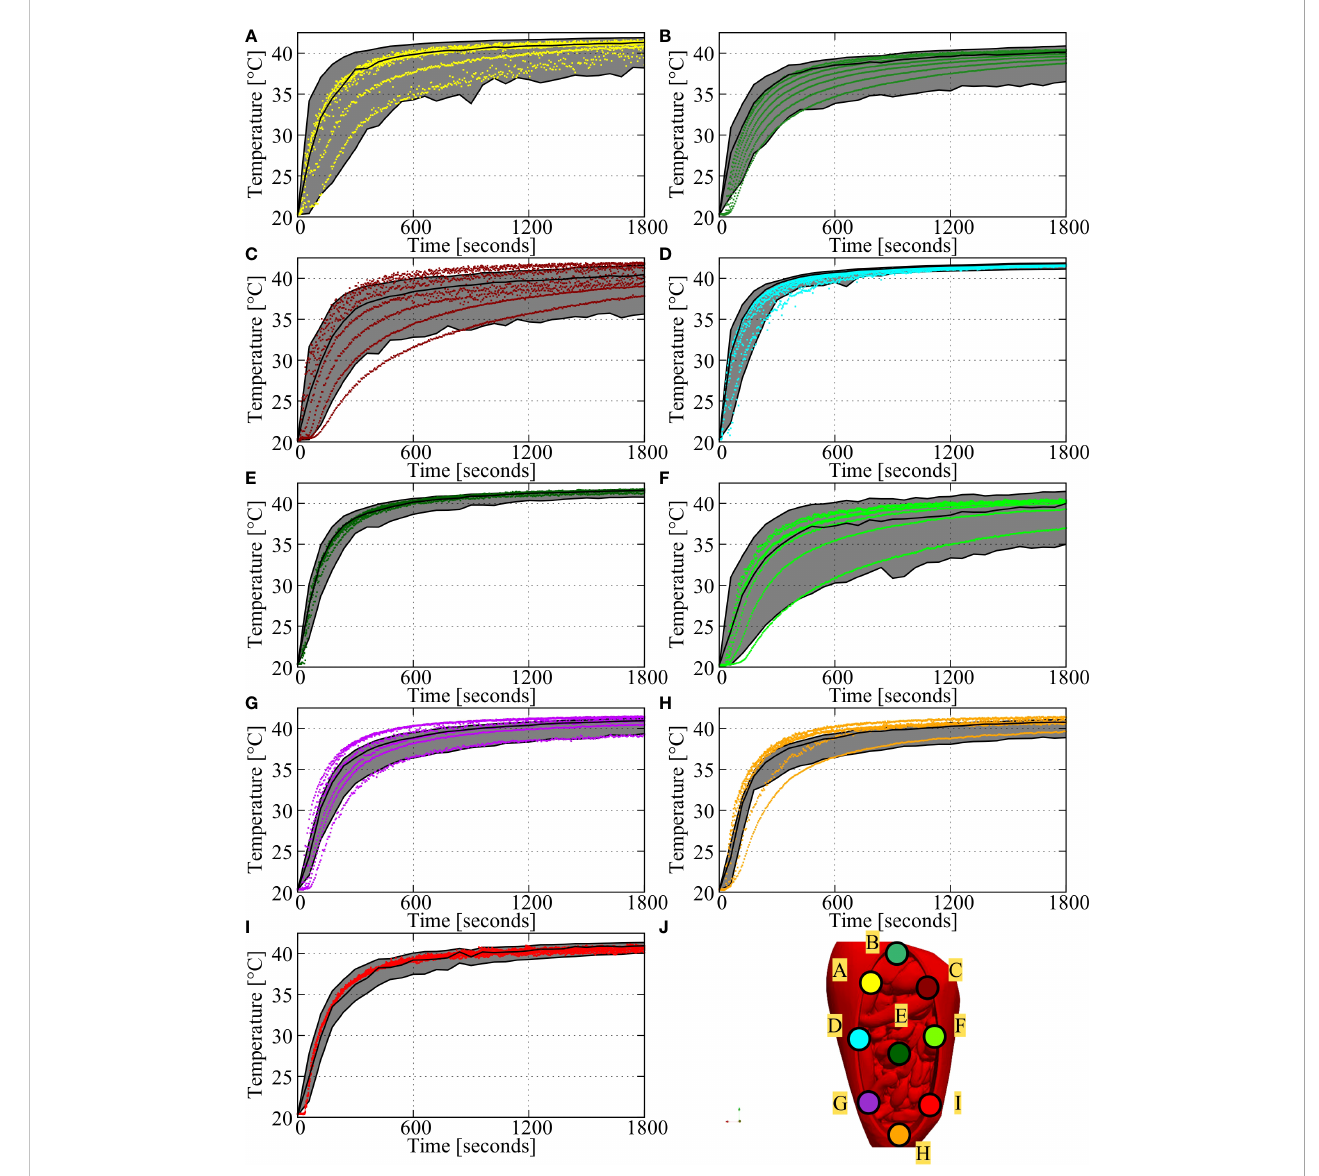
FIGURE 5 Comparison of measurements and predicted thermal ranges for the baseline setup (case # 1). (A-I) shows the comparison for region 1-9, with the locations of these regions shown in (J) . Simulated averages and ranges are represented by the black lines and shaded areas and measurements are represented by the colored dots. Measurements were taken every 5 seconds, with probes featuring 7 measurement points per probe. Therefore, each plot shows 2520 measurements over the duration of the experiment. In general, measurements fall within the predicted ranges, especially near steady state (last 5